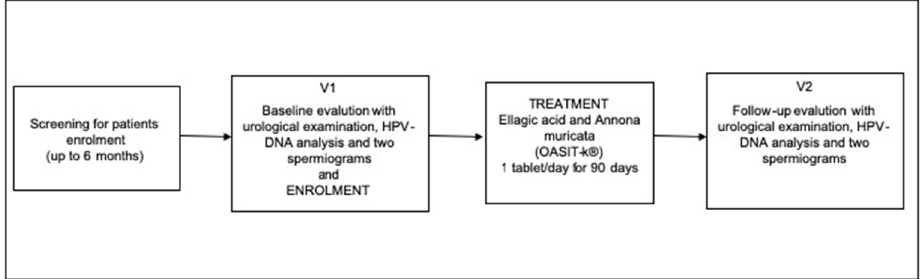
Figure 1. The study schedule.